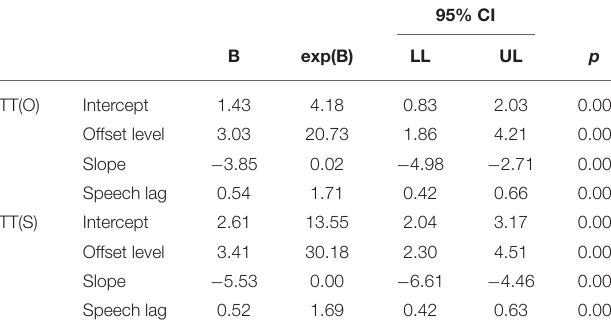
TABLE 4 | Coefficients of the inhalatory model for WSS+INH, TT(O), and TT(S)